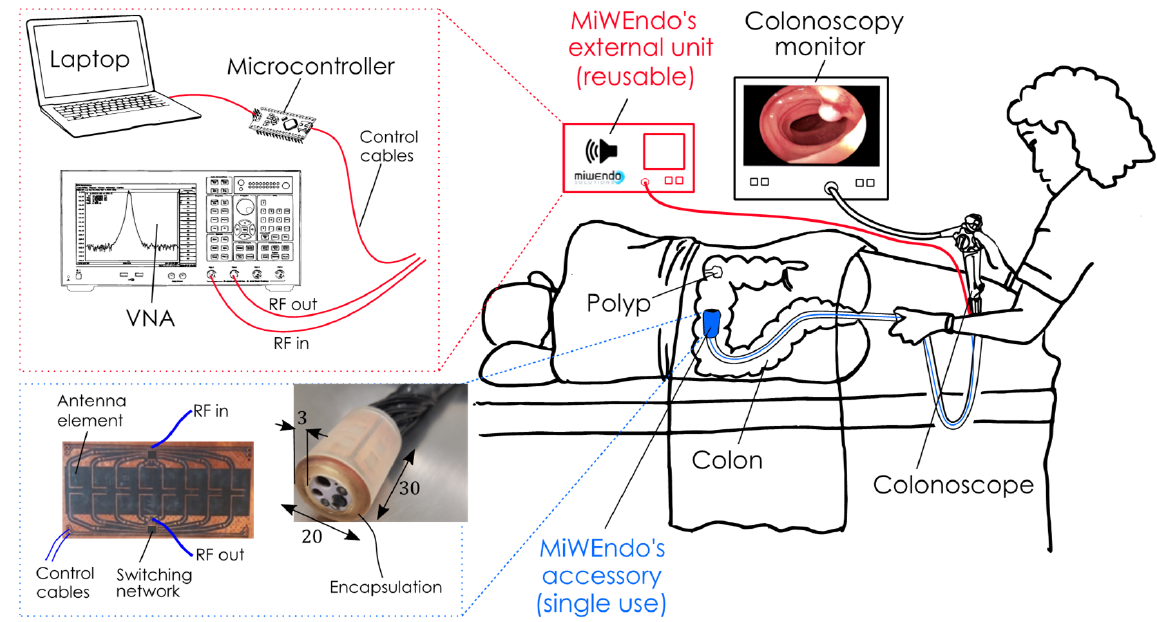
Figure 1. MiWEndo’s microwave endoscopy system is composed by an accessory attachable at the distal tip of a standard colonoscope ( bottom left ) and an external processing unit ( top left ). MiWEndo generates an acoustic signal when a polyp is detected to warn the endoscopist during a colonoscopy exploration ( right ). Encapsulation size is in mm.